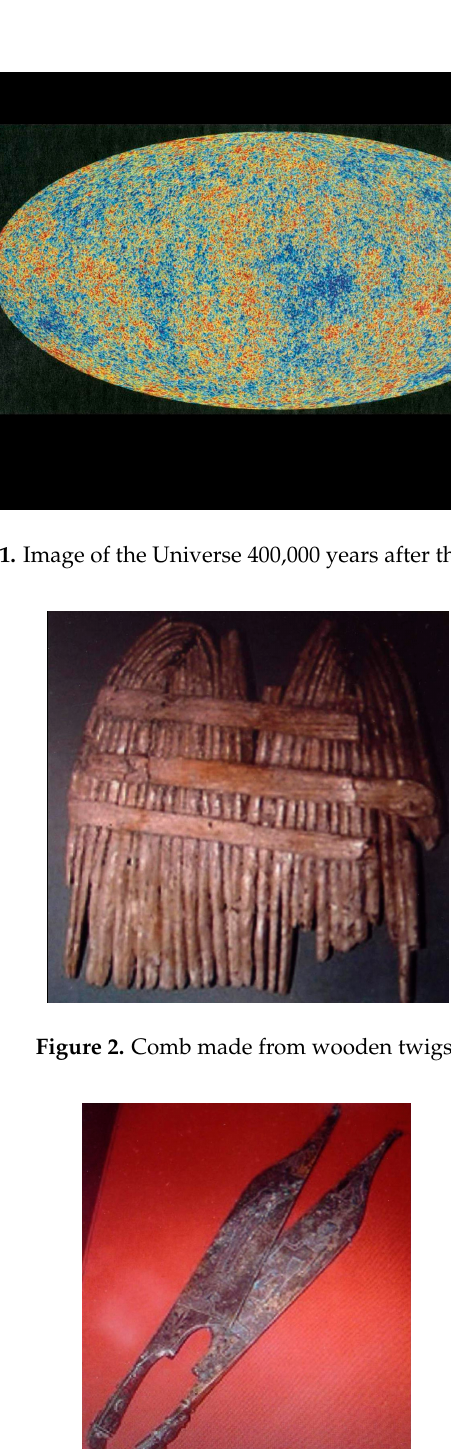
Figure 3. Scissors from the bronze age.